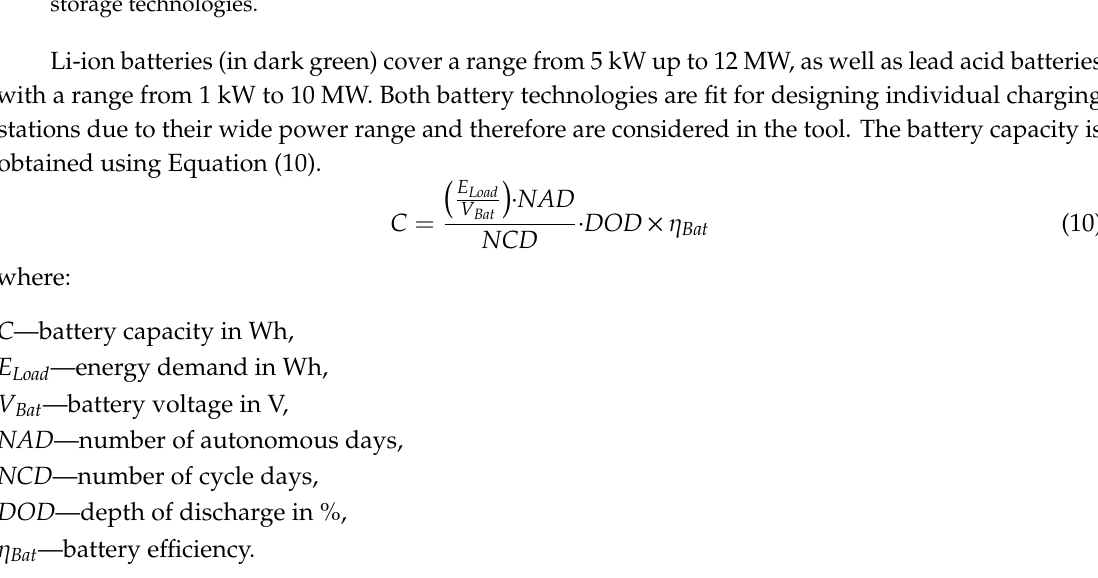
Figure 7. Comparison of rated power, energy content and charge/discharge times for different storage technologies. storage